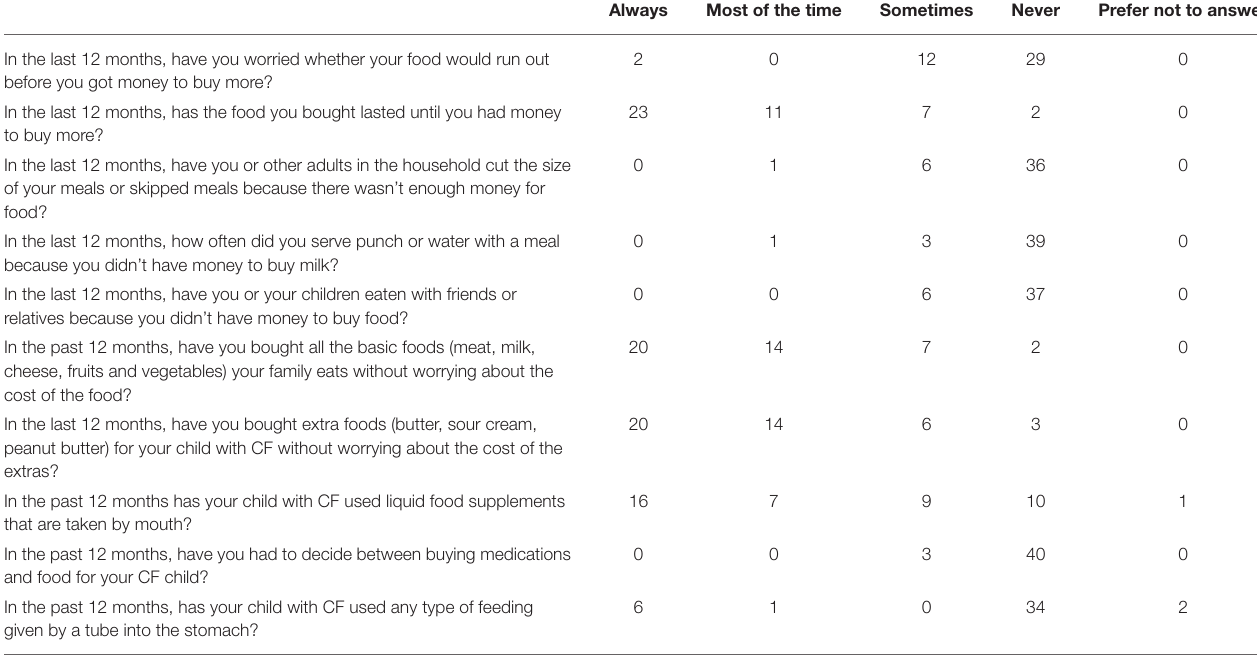
TABLE 2 | Results of food security tool completed by parents of children with cystic fibrosis. Always Most of the time Sometimes Never Prefer not to